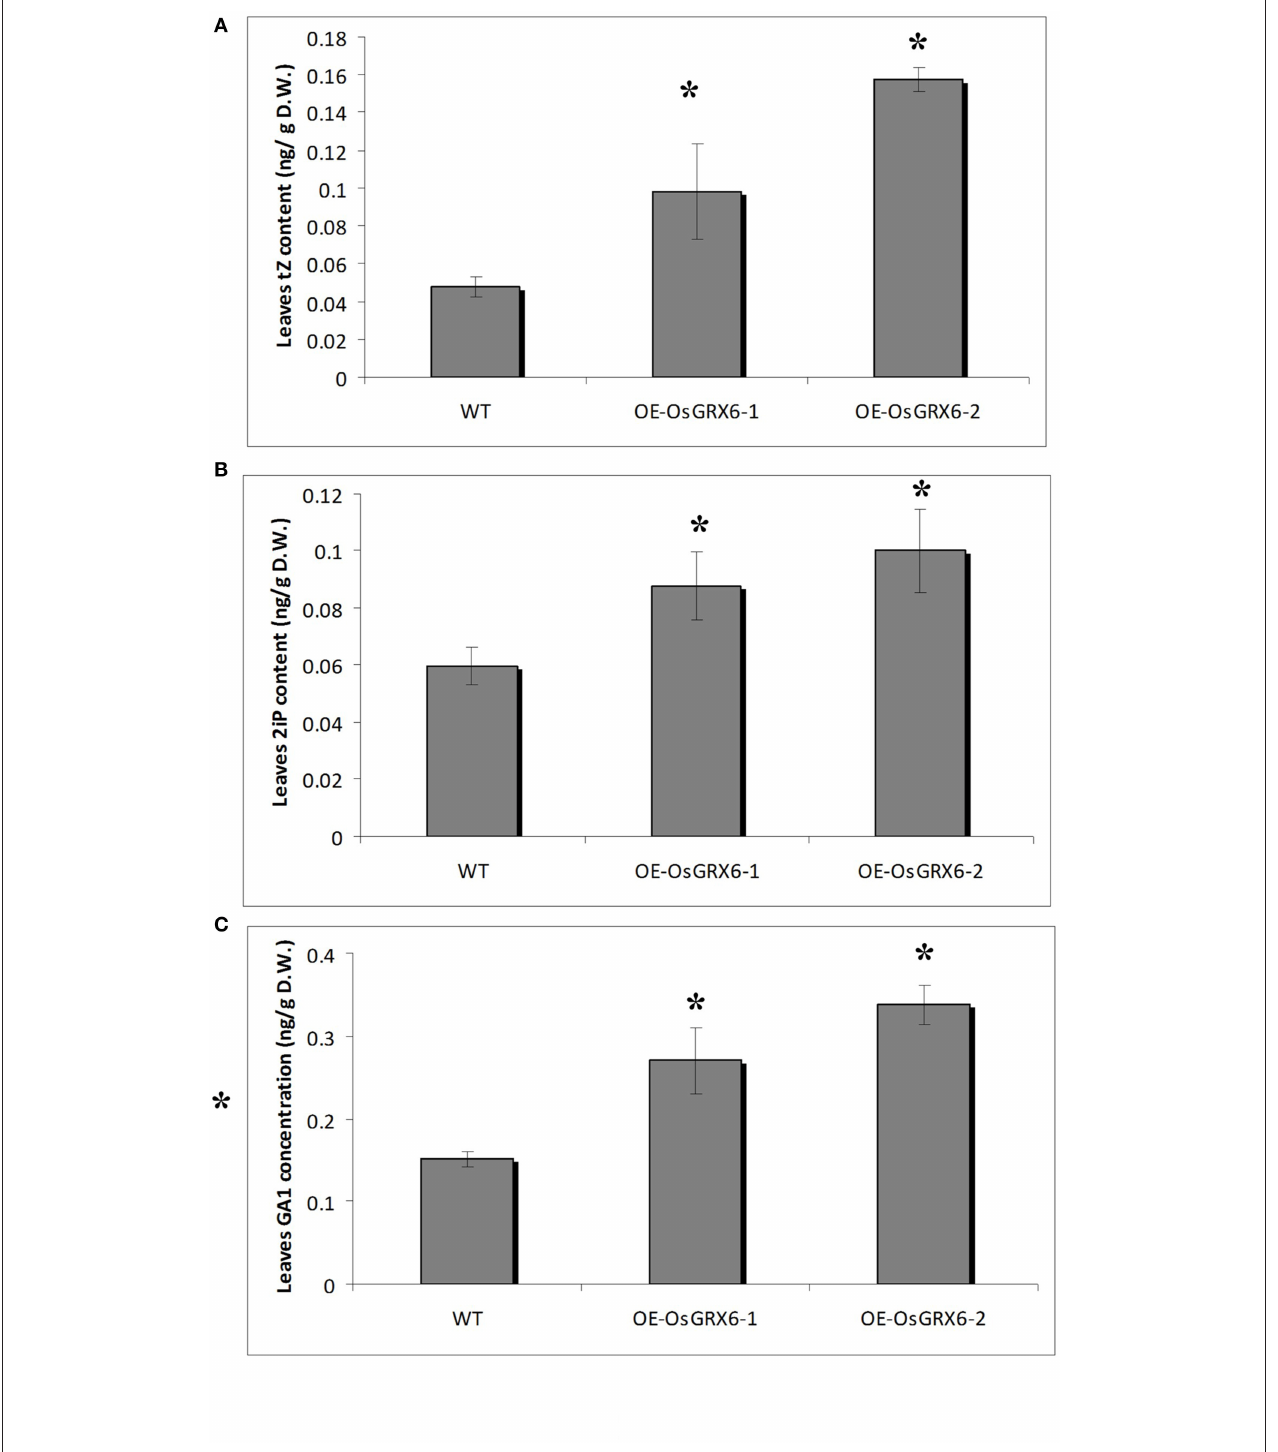
FIGURE 8 | Cytokinin and GA1 content in rice plants. The contents of trans-zeatin (A) . N6 − ( 1 2-isopentenyl) adenine (B) and the major bioactive GA1 (C) in the leaves of 4 weeks old wild-type and transgenic plants growing in the full nutrient medium as described in the materials and method section. Data is a mean of three replicates ( ± SD). Asterisks indicate significant differences at p ≤ 0.05